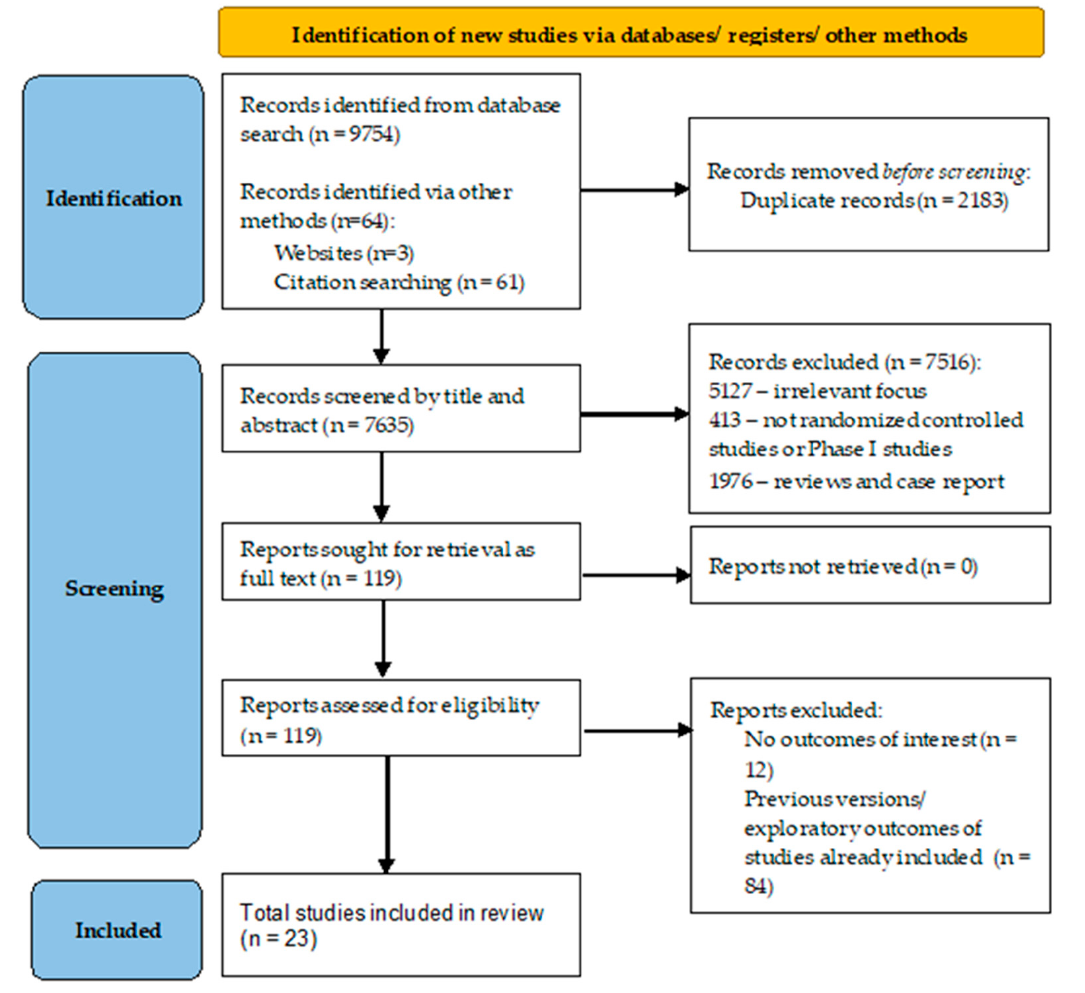
Figure 2. The literature search flow diagram.